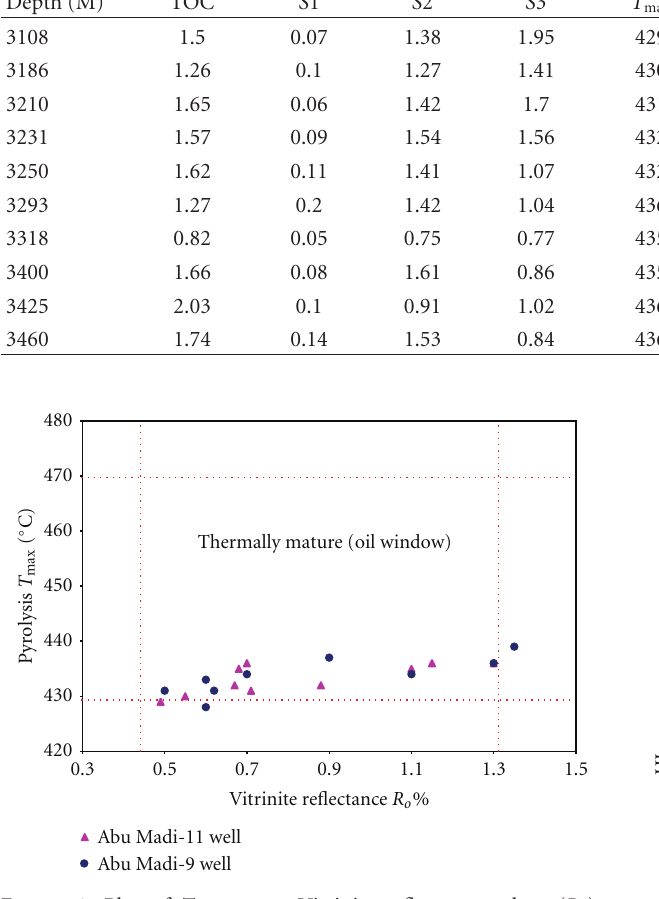
Figure 3: Plot of T max versus Vitrinite reflectance values ( R o ), showing good agreement between T max and Vitrinite reflectance data.